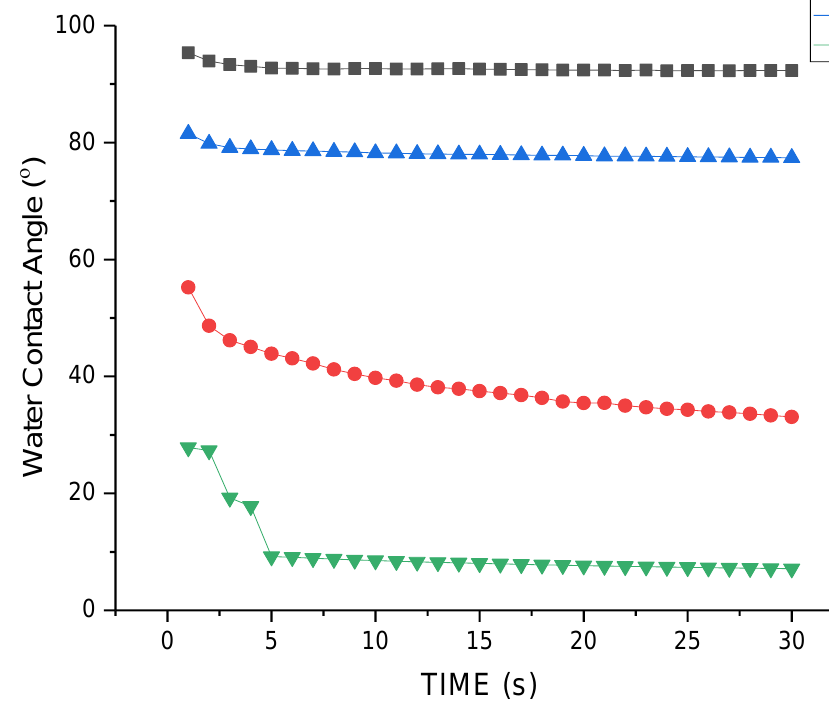
Figure 10. Dynamic contact angle of different types coating onto PSF